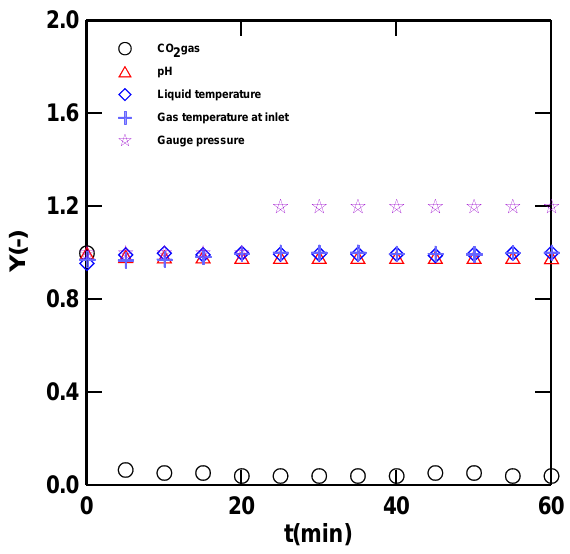
Figure 3. A plot of X vs. t, showing the steady-state operation (No.1). Table 4. Experimental data obtained in this study.